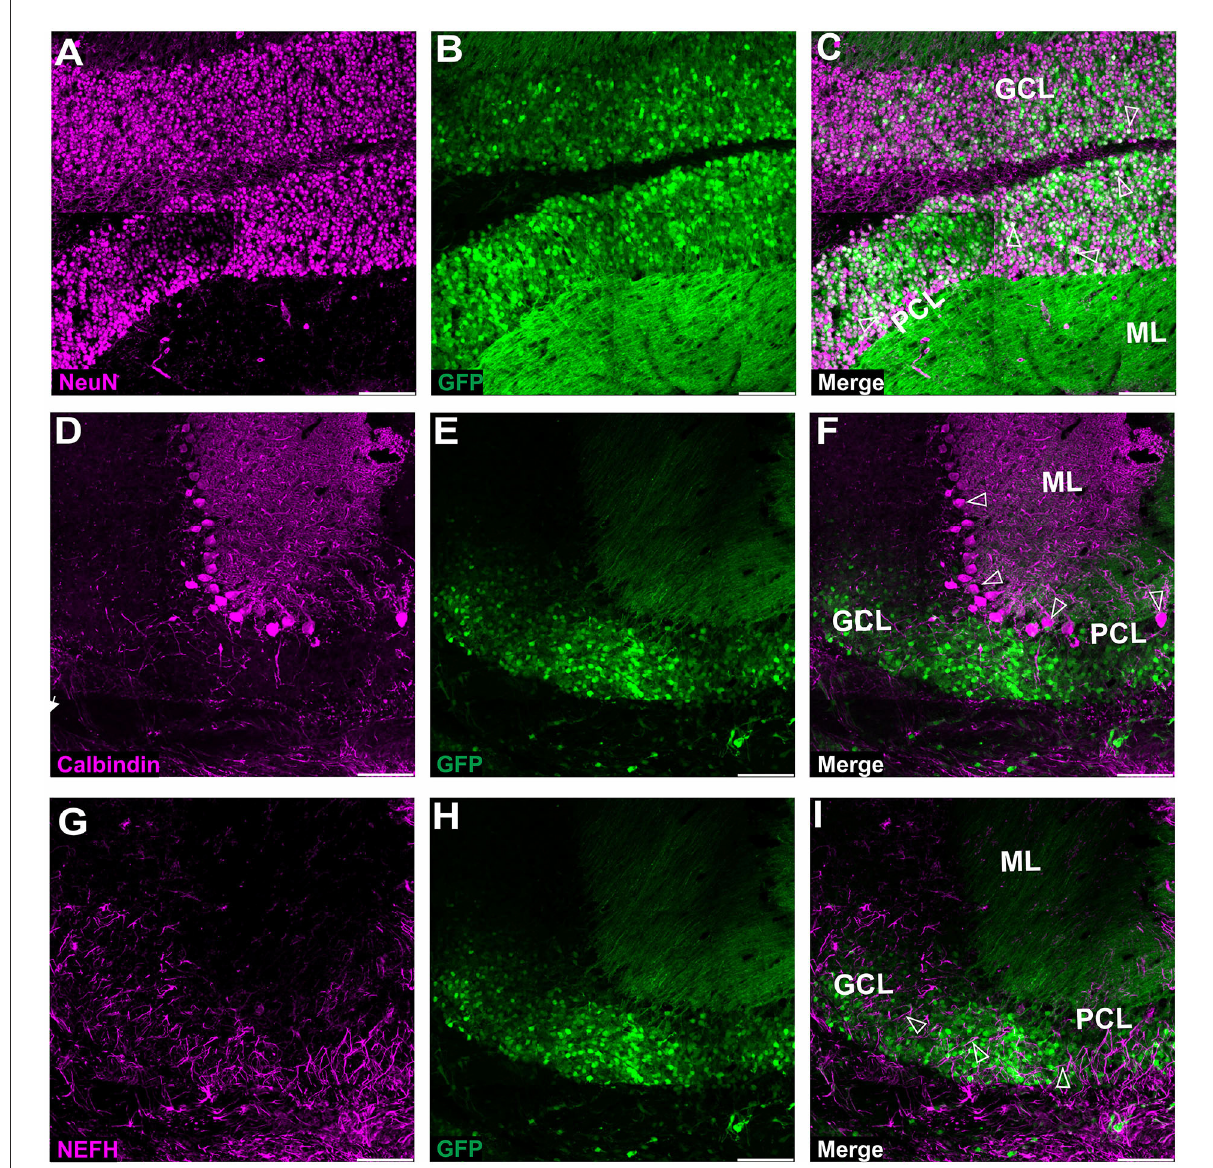
FIGURE3 Fluorescent coimmunostaining of mouse cerebellar cryosections between 10 and 20 weeks after lobular AAVrh10 injections. eGFP green signal (B,E,H) was imaged together with NeuN (magenta) or calbindin 1 (magenta) or NEFH neurofilament (magenta). The granule cell marker, NeuN (A) , co-localized with green cells (B) , showing an overlayed white signal (C) . Immunostaining for Purkinje cell marker calbindin 1 (D) did not reveal any co-localization with eGFP signal (F) . The NEFH marker, which is known for staining Purkinje and basket cell processes in the cerebellum (Wiatr et al., 2021) did not co-localize with eGFP (G) . Unfilled arrowheads: co-localized in granule cells (C) ; or Purkinje cell bodies (F) ; or neurofilaments (I) . GCL, granule cell layer; ML, molecular layer; PCL, Purkinje cell layer. Coronal section. Bars: 100 µ m in the lower right corner of images. A slight misalignment of the composite images in (A–C) panels is due to the optical properties of Opera Phenix. Images acquired from N = 3